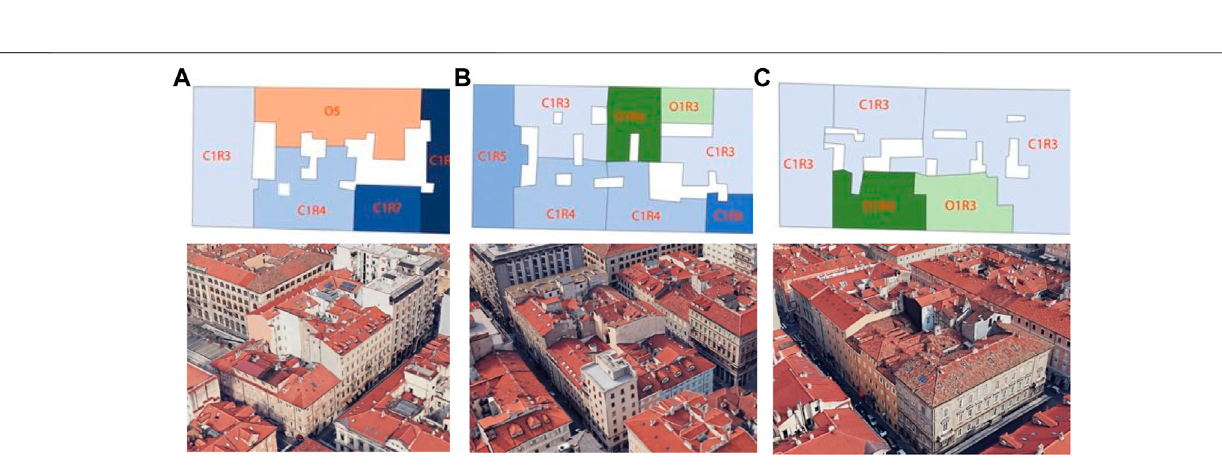
Frontiers in Energy Research |